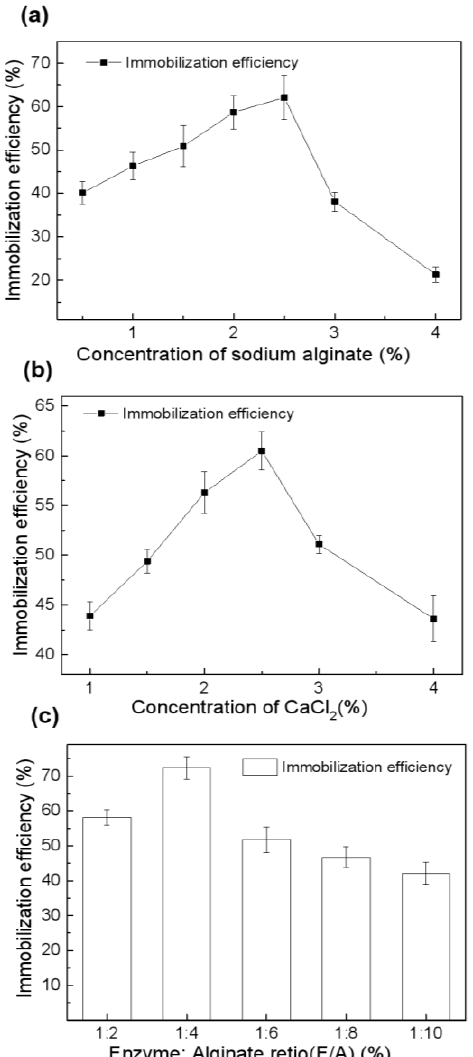
Figure 3. The optimization of entrapment conditions for Melac13220; ( a ) the optimization of sodium alginate concentration; ( b ) the optimization of calcium chloride concentration; ( c ) the optimization of enzyme/alginate ratio. All the results are represented as the means ± standard deviation from at least three independent experiments.